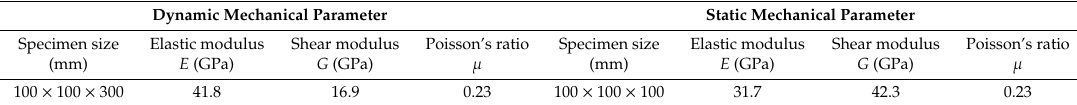
Table 6. The mechanical parameters of the